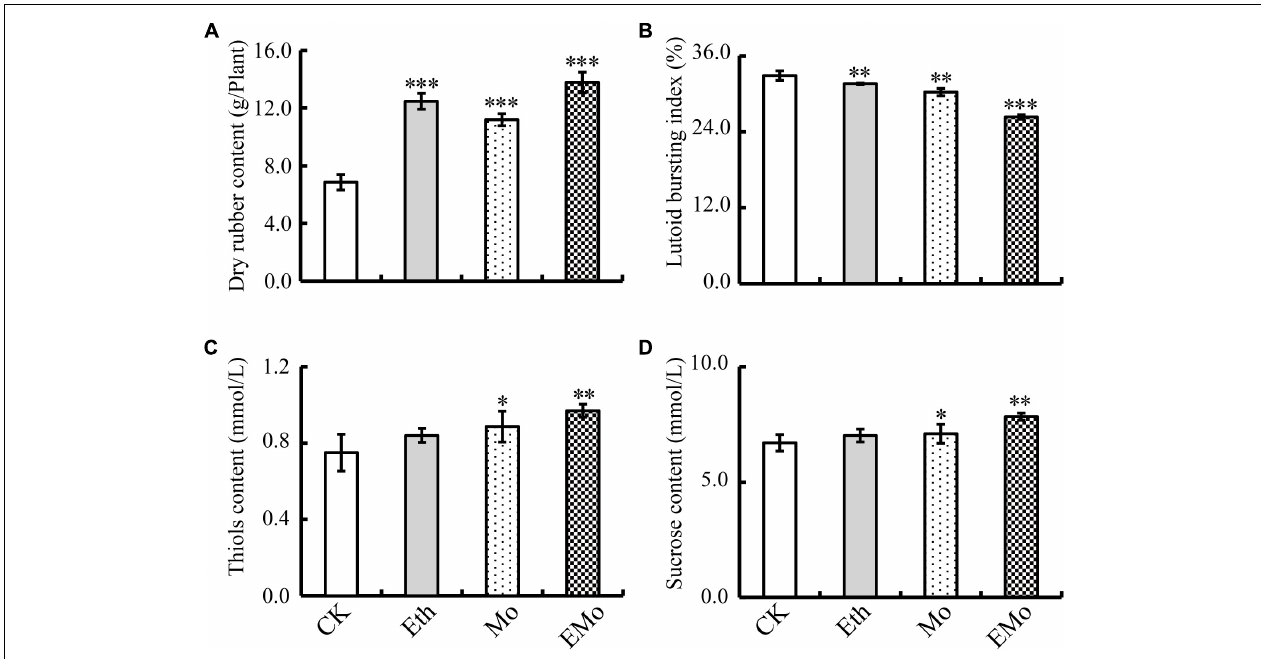
FIGURE 1 | Changes in rubber latex parameters under different treatments. The dry rubber content (A) , lutoid bursting index (B) , thiol content (C) , and sucrose content (D) in the latex collected from rubber trees treated with control (CK), 0.5% ethylene (Eth), 1.5% ammonium molybdate (Mo), and 0.5% Eth +1.5% ammonium molybdate (EMo) were highlighted. Values are the mean ± SD ( ∗ P ≤ 0.05, ∗∗ P ≤ 0.01, and ∗∗∗ P ≤